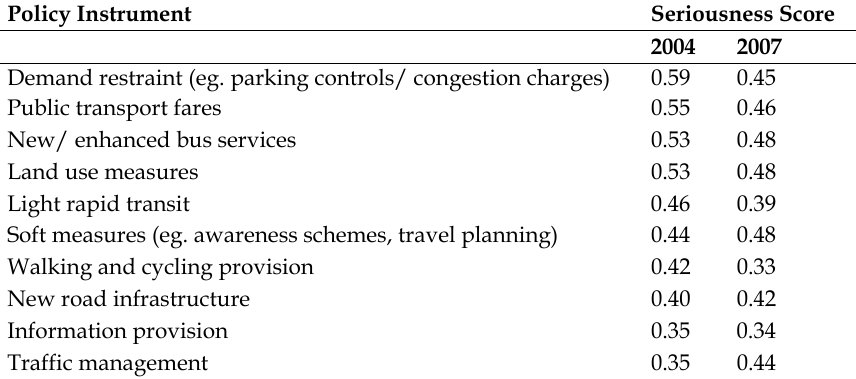
Table 4. Modelling of Policy